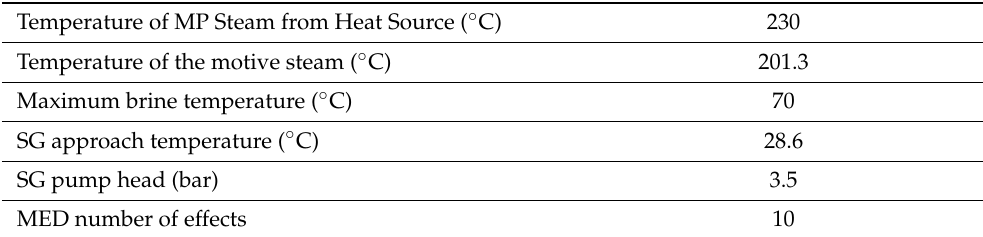
Table 6. MED-TVC input parameters in